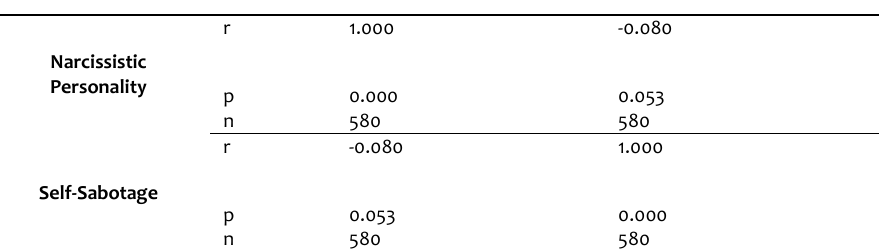
Table 6: Pearson Correlation Coefficient between Narcissistic Personality Level and Self-Sabotage Level Narcissistic Personality